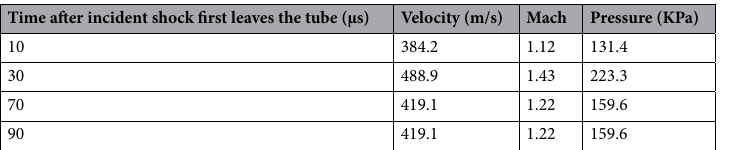
Table 2. Incident shock wave data.